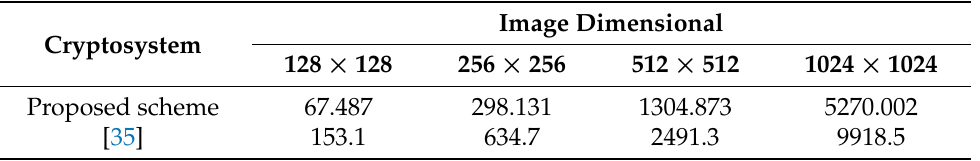
Table 17. Comparative analysis of encryption speed (ms) for the suggested cryptosystem and other